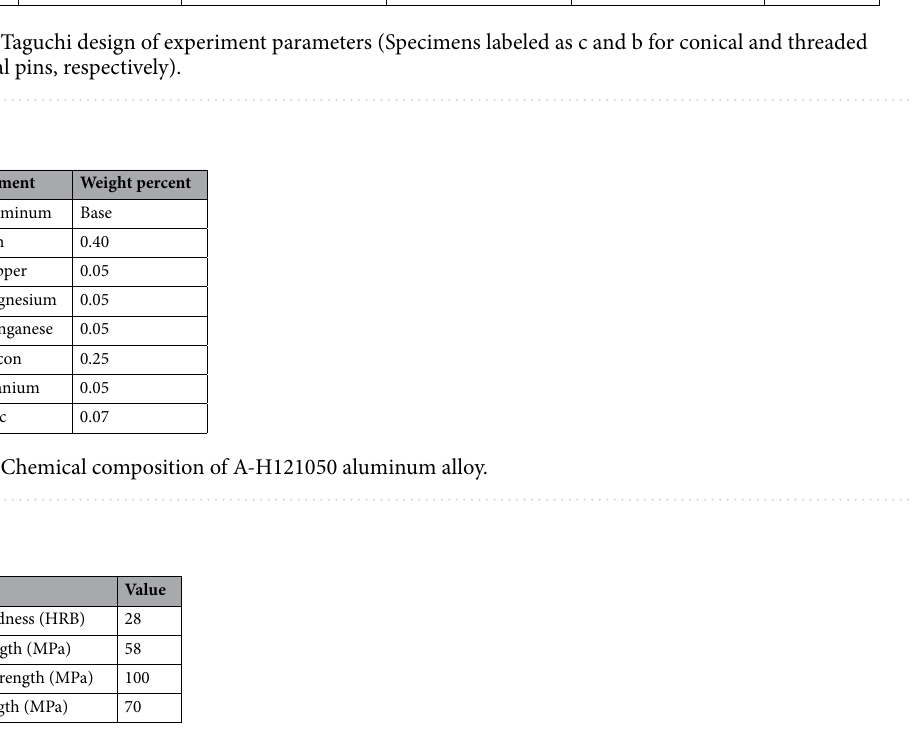
Table 3. Mechanical properties of A-H121050